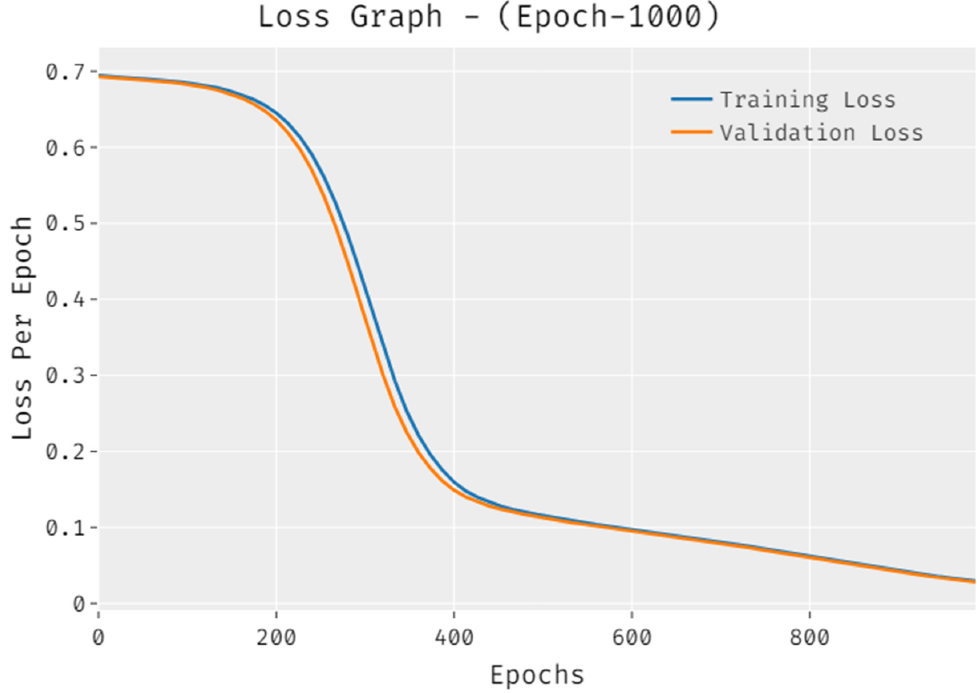
Figure 12. Loss graph analysis of DLSODC ‐ GWM technique under 1000 epochs.